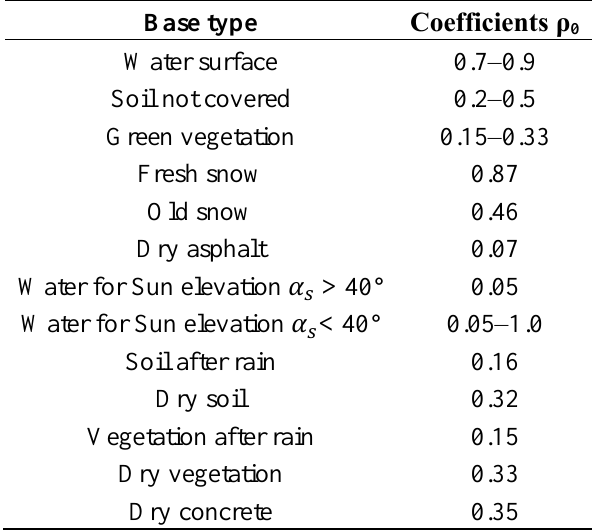
Table 1. Reflectivity coefficients for various types of bases